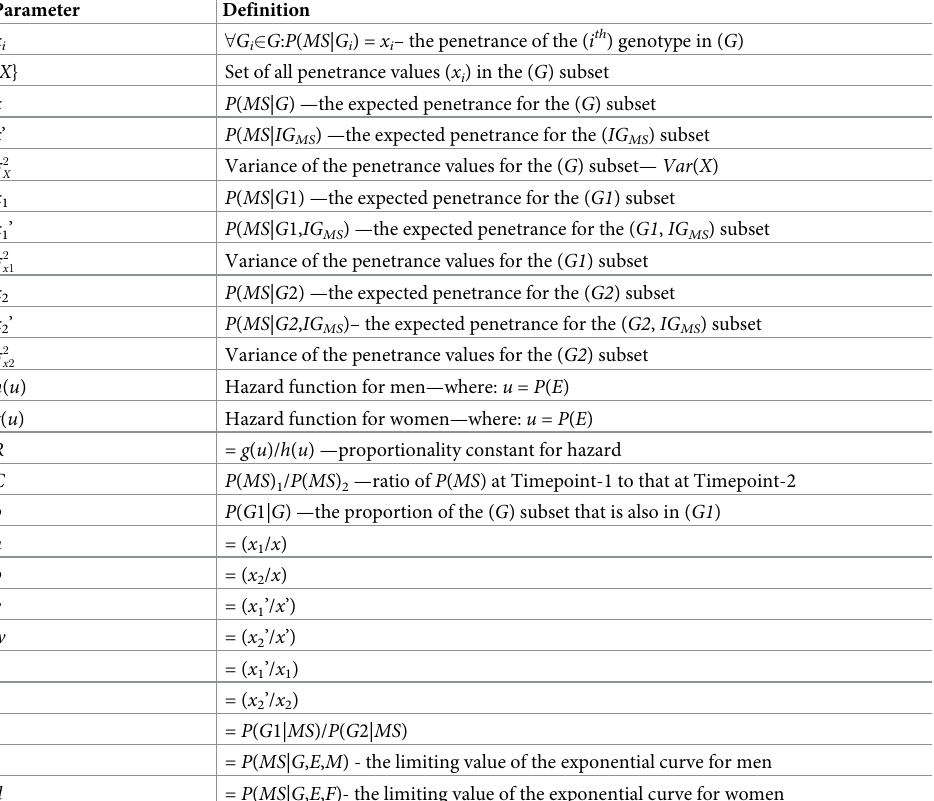
Table 2. Principal parameter abbreviations.